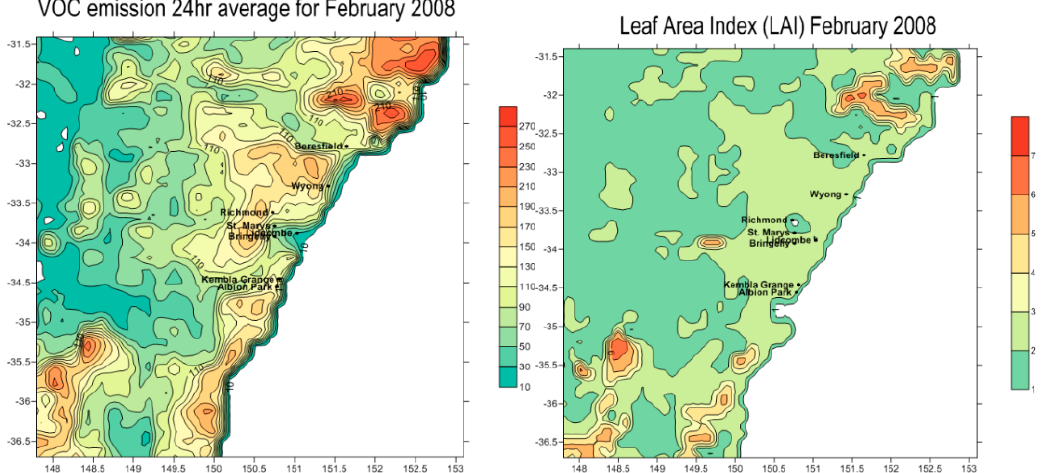
Figure 4. VOC monthly 24-hourly average emission (kg/hour) ( left ) and Leaf Area Index (LAI) ( right ) for February 2008.